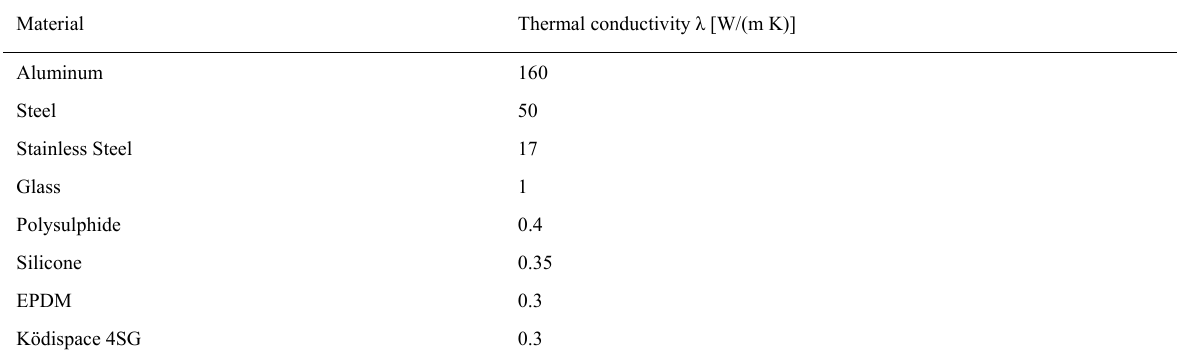
Table 4: Examples of the thermal conductivity of materials according to EN ISO 1007-2 Annex A